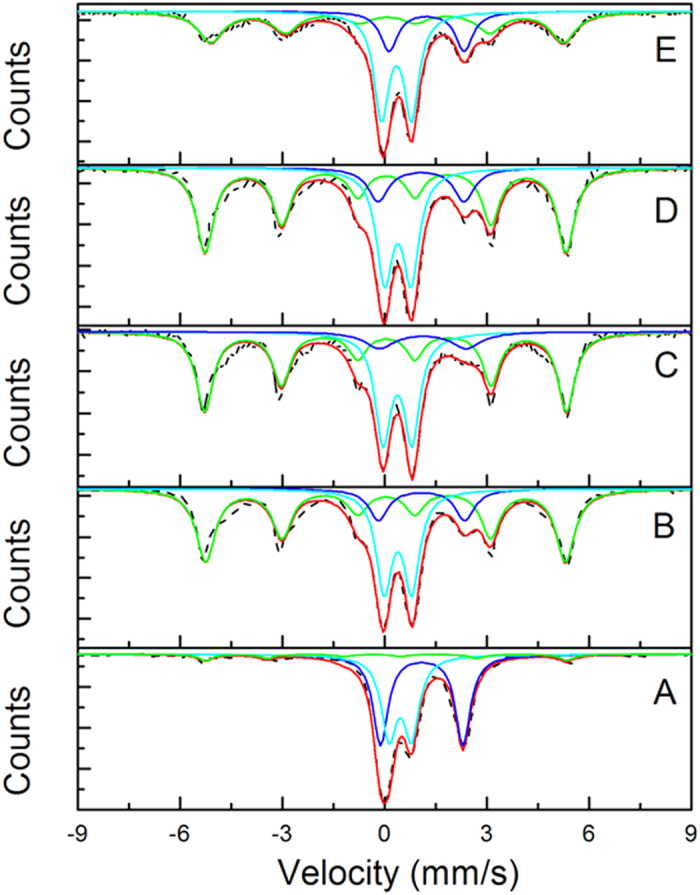
Room-temperature Mössbauer spectra of (A) S-nZVI (in glass), (B) FeSSi-0.012 g nano-SiO2, (C) FeSSi-0.048 g nano-SiO2, (D) S-nZVI-0.064 g nano-TiO2, and (E) S-nZVI-0.082 g nano-Al2O3. (- -, original line; , total fitting line; , Fe0; , Fe2+; , Fe3+;).